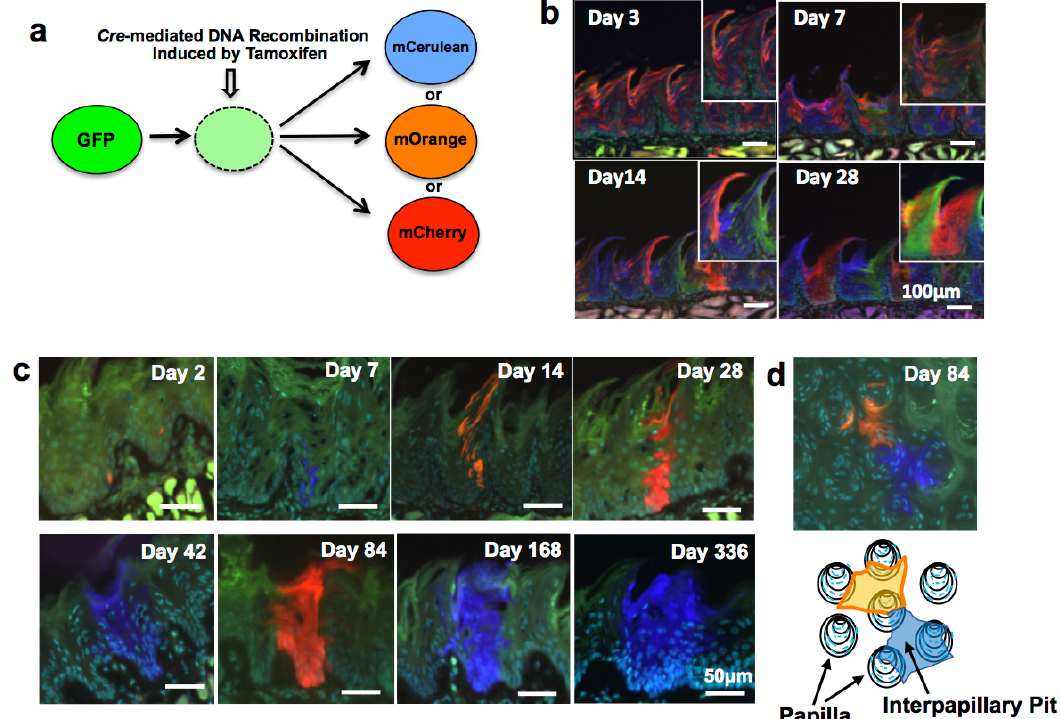
Figure 1. ( a ) Cre -mediated fluorescent color change. Fluorescent labels of cells change from green to either red, orange, or blue upon tamoxifen-induced Cre -mediated excision of floxed cassettes; their descendant cells retain the new color; ( b ) Individual cells of Rosa26CreERT2; Rosa26-rainbow mice injected with tamoxifen were labeled and analyzed at the indicated time points. Magnified images are shown at the right upper corner of the images; ( c ) Fate of cells derived from Bmi1-positive cells. Bmi1-CreER; Rosa26-rainbow mice were injected with tamoxifen and analyzed at the indicated time points; ( d ) Areas maintained by single Bmi1-positive stem cells. Three (and less frequently four) filiform papillae displayed different colors, suggesting that Bmi1-positive LESCs are present in the middle of the pit. This figure is a modified version of figures presented in our previous report [8].